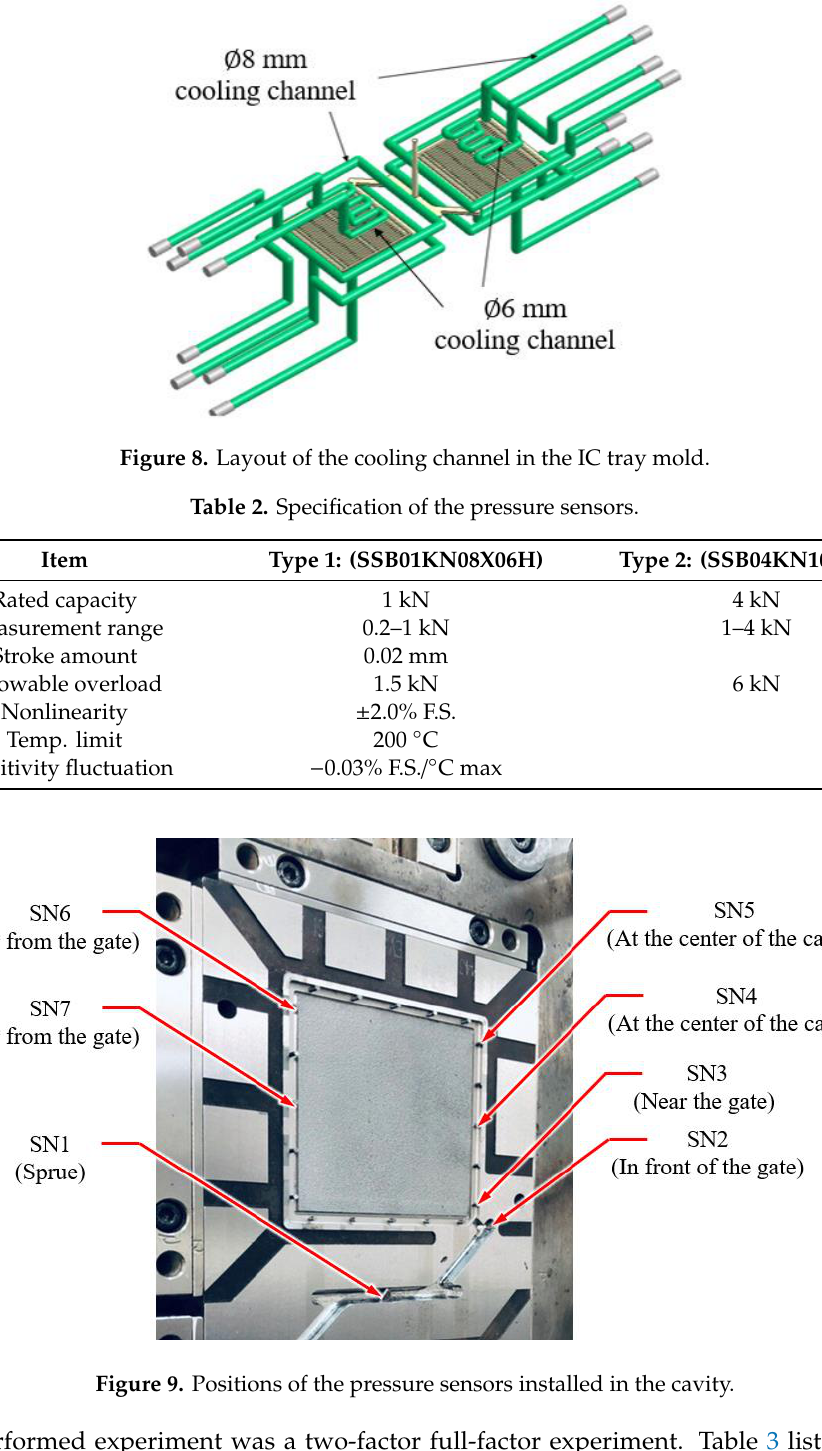
Table 3. Parameters of the injection molding process.